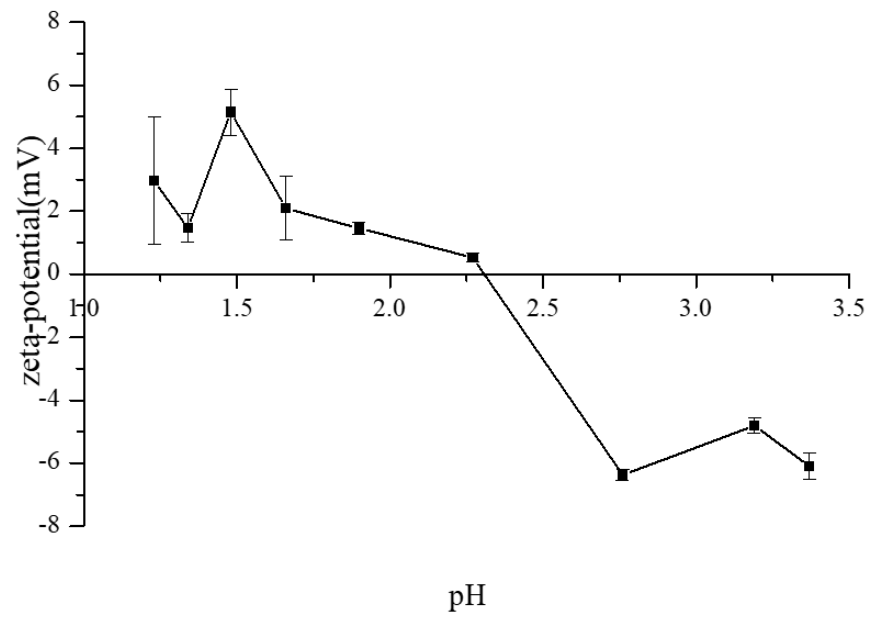
Figure 4. Evaluation of zeta potential as a function of pH for CAH liquor during ED deacidification